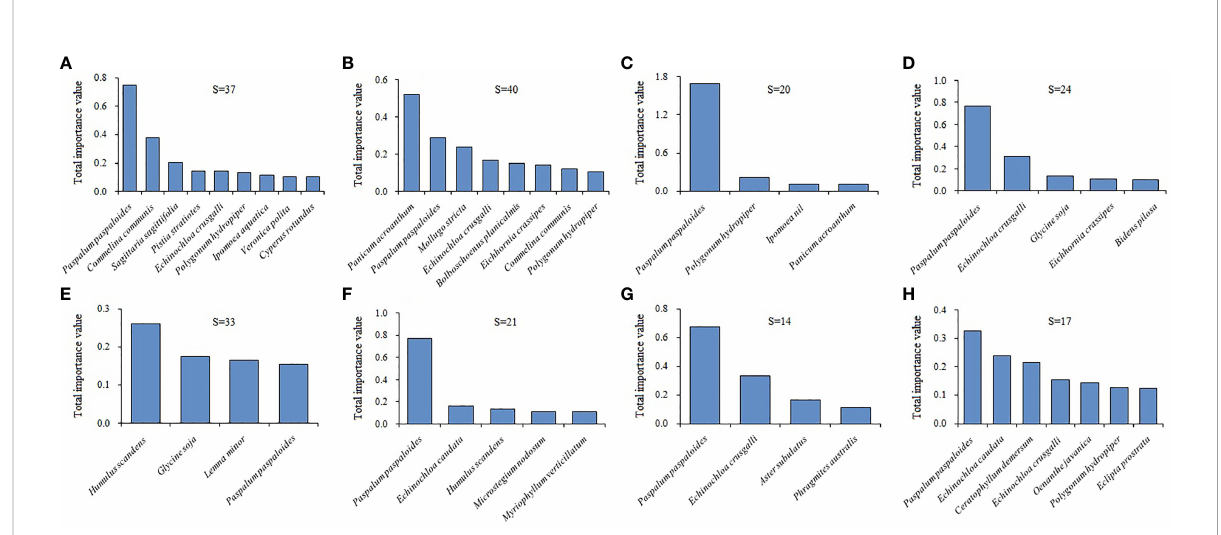
FIGURE 4 Variations in the dominant accompanying plant species of the A . philoxeroides communities among different latitudinal clusters in aquatic habitats. (A – H) represent the 1 to 8 latitudinal clusters,